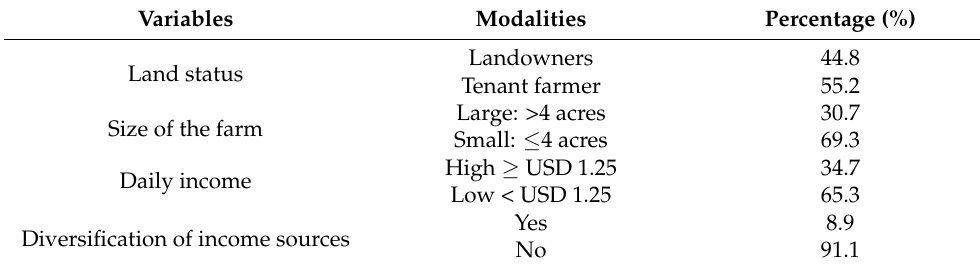
Table 4. Farmers’ economic